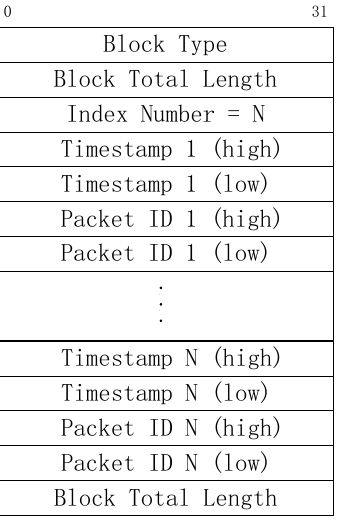
Figure 5. The Timestamp Index Block (TIB) format.